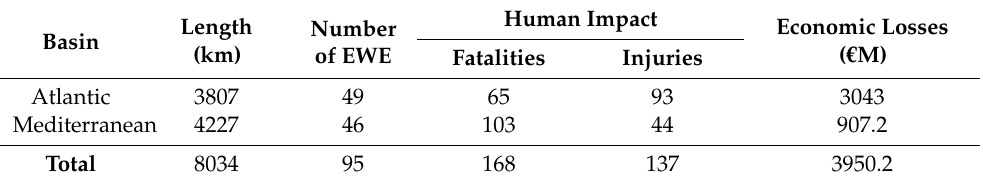
Table 2. Summary by basin (Atlantic and Mediterranean) of the number of extreme weather events recorded, fatalities, injuries and economic damage caused during the period analysed.